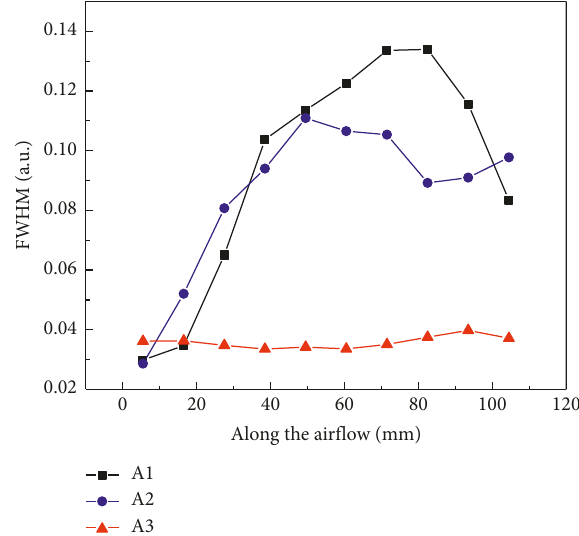
Figure 8: FWHM data of three oxy-fuel conditions in different